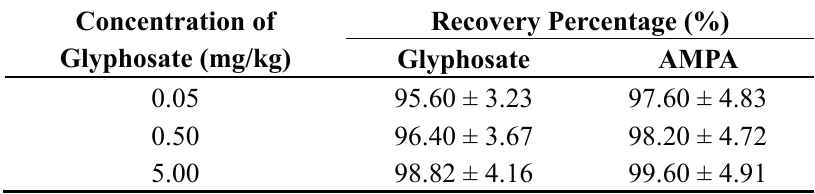
Table 1. Recovery percentage of glyphosate and its metabolite AMPA from soils in Zhejiang